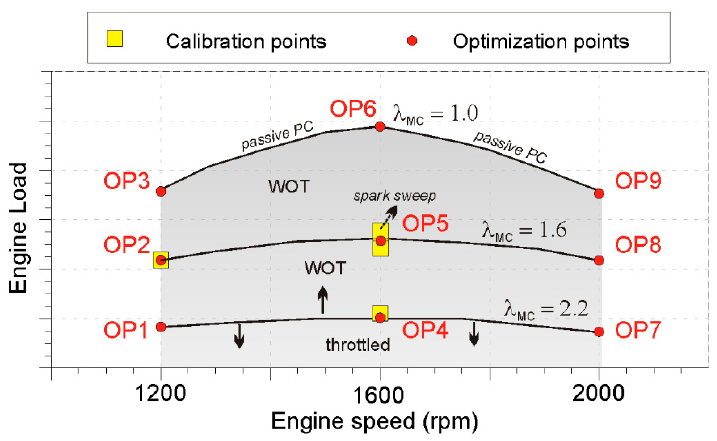
Figure 6. Positions of calibration and optimization operating points in experimental engine map.